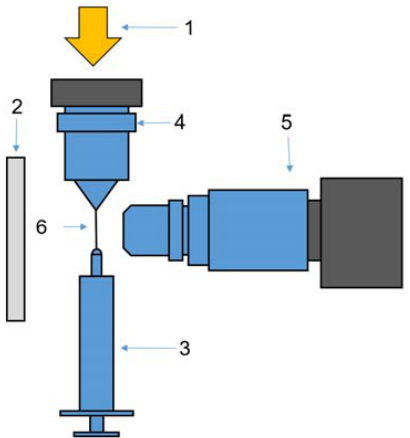
Figure 1. Experimental device for stretching a jet up to a definite length. 1—fiber-optic illuminator along the jet axis; 2—back lightening; 3—syringe with solution; 4—lens to focus the light into the center of an extended jet; 5—camera; 6—jet.